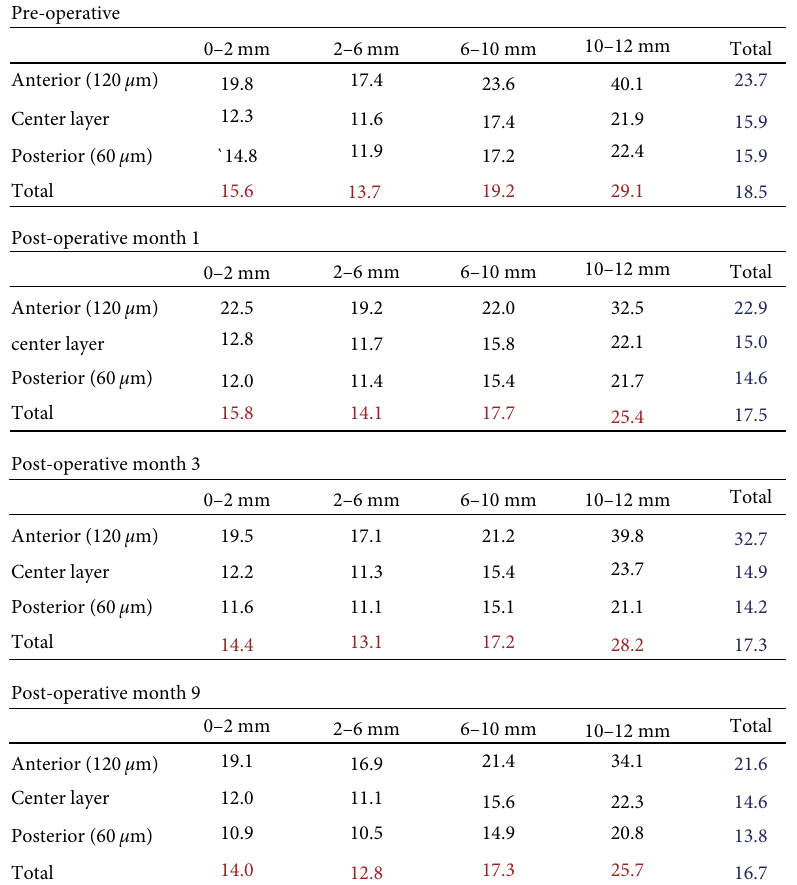
Figure 5: Corneal densitometries pre- and post-DSO for the left eye. Decrease in densitometry is noted not only in the posterior layer centrally (the region of Descemet’s stripping), but also in the posterior layer peripherally and in the anterior layer